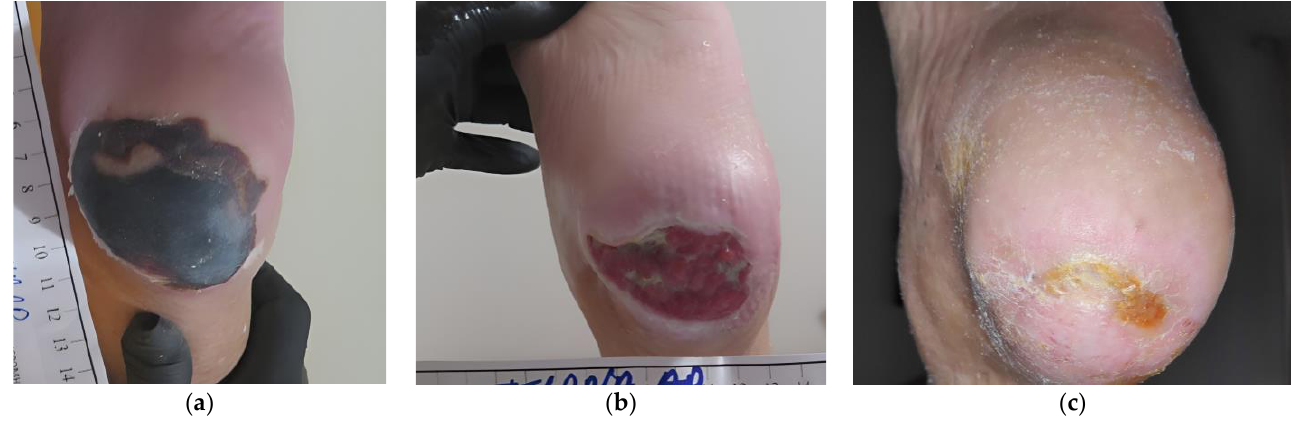
Figure 4. Case 4: ( a ) clinical findings at the initial examination, day 0 (start of MGH treatment); ( b ) elimination of local signs of infection and advanced wound healing after 8 weeks of MGH therapy; ( c ) complete wound healing after 24 weeks of MGH therapy.